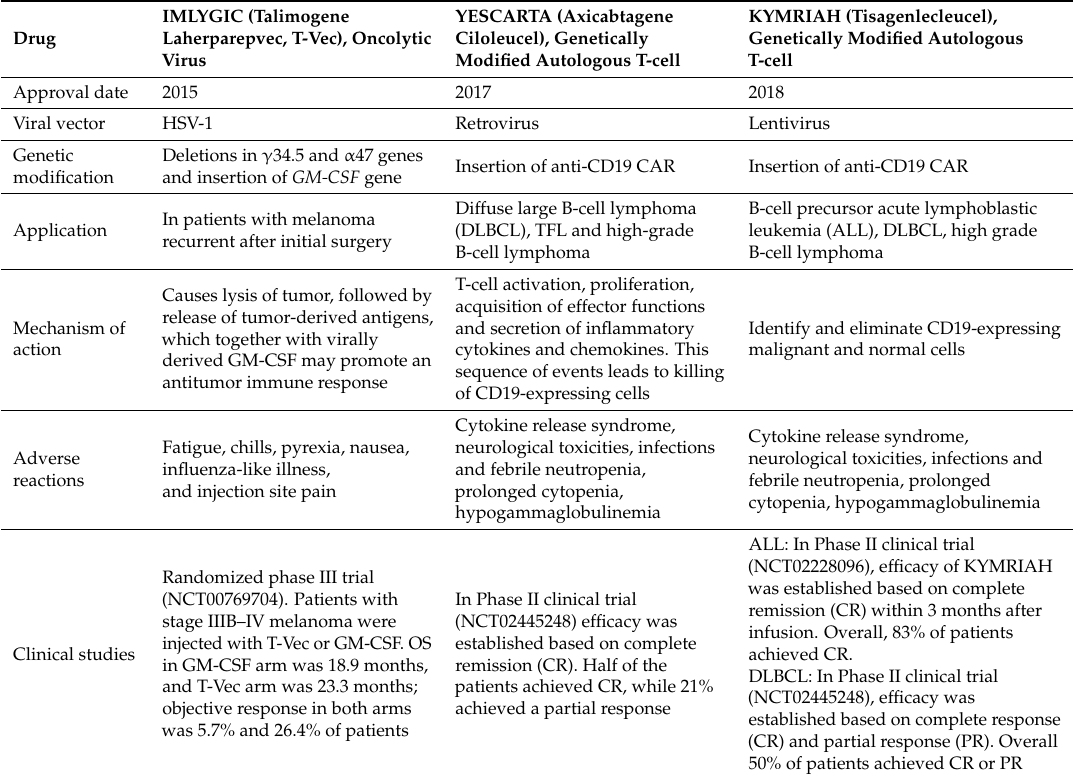
Table 2. FDA approved recombinant virus-based